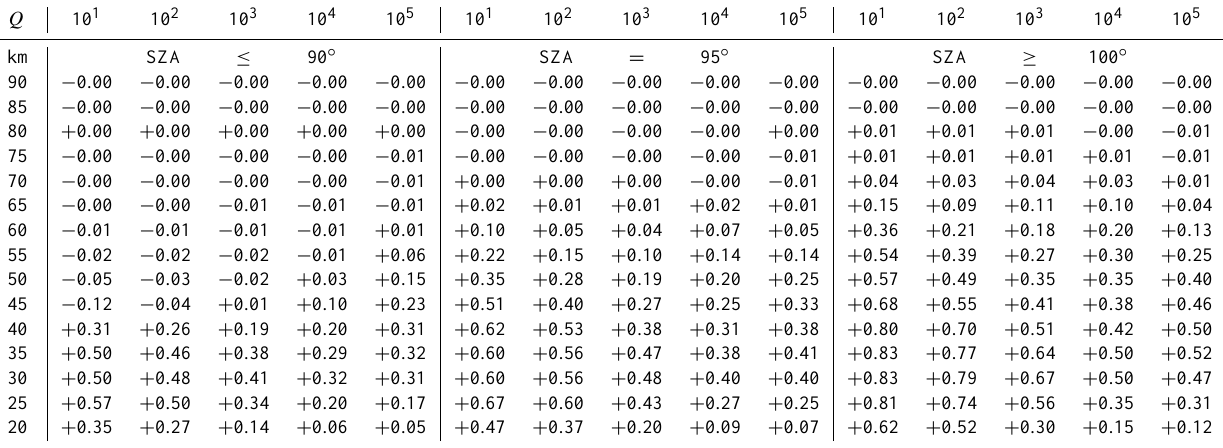
/Q for October SH. 3